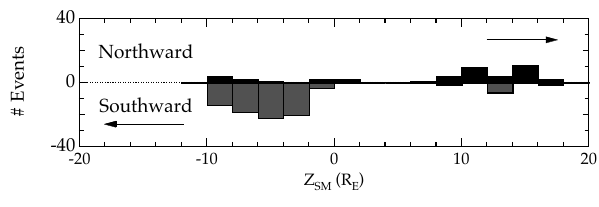
Fig. 13. The direction of motion in which the events move as in- ferred from the sense of their bipolar signatures and the background magnetic field. Almost all events observed south of the geomag- netic equator (Z=0) move southward, while almost all events ob- served north of the geomagnetic equator move